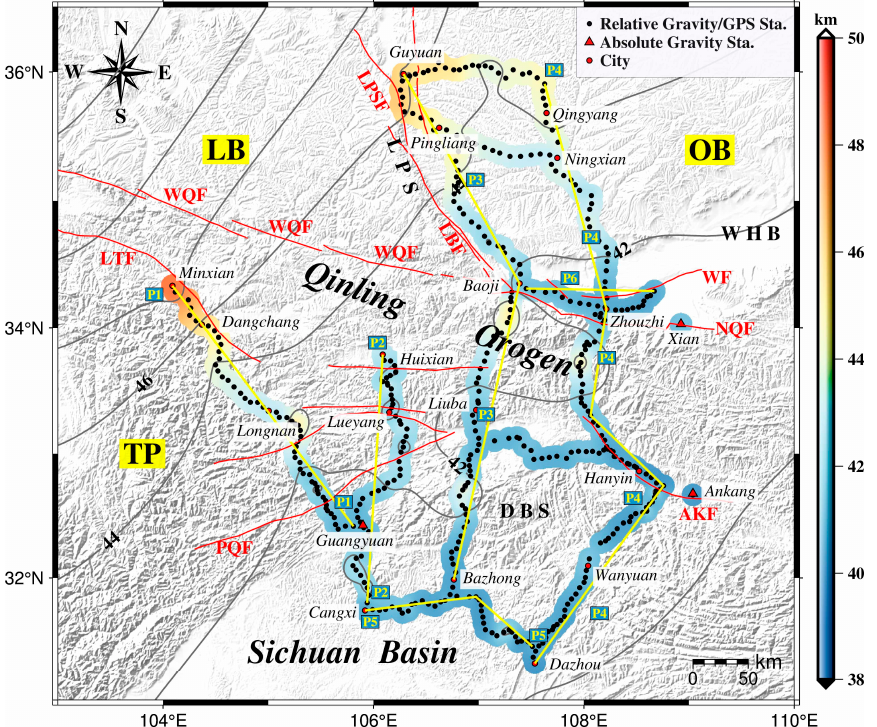
Figure 5. The isostatic depth map in the Qinling area. Abbreviations are the same as those used in Figure 1.